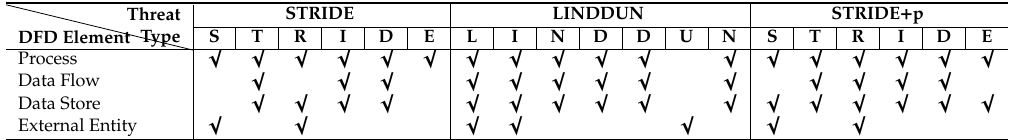
Table 1. Comparison of STRIDE, LINDDUN and STRIDE+p threats.